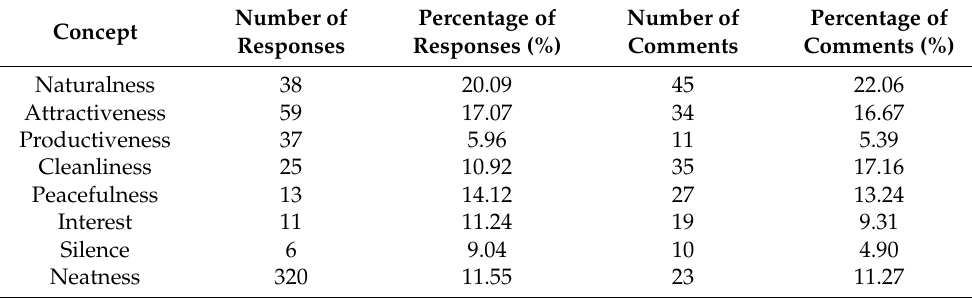
Table 4. Responses and comments by